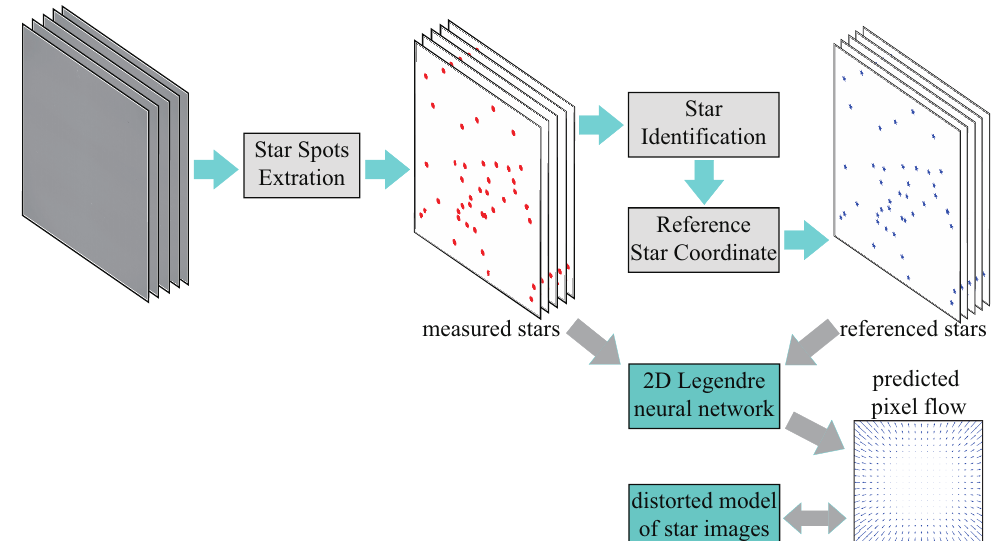
Figure 3. On-orbit geometric distortion correction procedures.